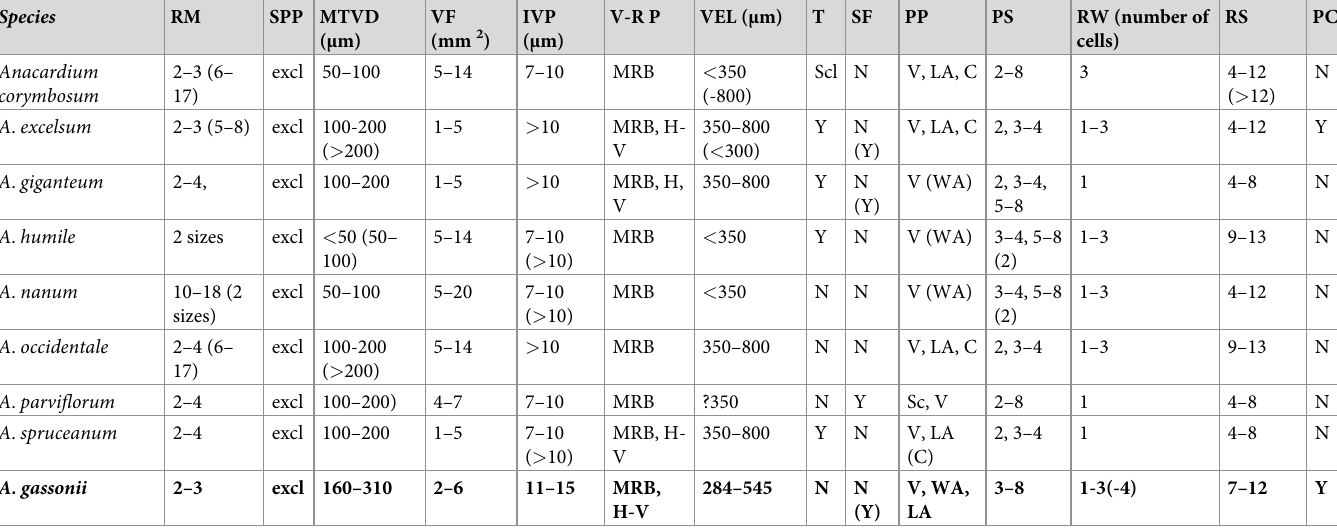
RM = radial multiples; SPP = simple perforation plates; MTVD = mean tangential vessel diameter; VF = vessel frequency; IVP = intervessel pits size; V-R P = vessel ray pits; VEL = vessel element length; T = tyloses abundant; SF = septate fibers; PP = parenchyma pattern. PS = parenchyma strand length; RW = ray width in number of cells; RS = ray spacing. PC = prismatic crystals. Character state codes: excl = exclusively; MRB = vessel-ray pits with much reduced borders; H = horizontally elongated pits; V = vertical pits. Scl = sclerotic tyloses; Y = yes; N = no; V = vasicentric parenchyma; LA = lozenge aliform parenchyma; C = confluent parenchyma; WA = winged aliform; Sc = scalariform